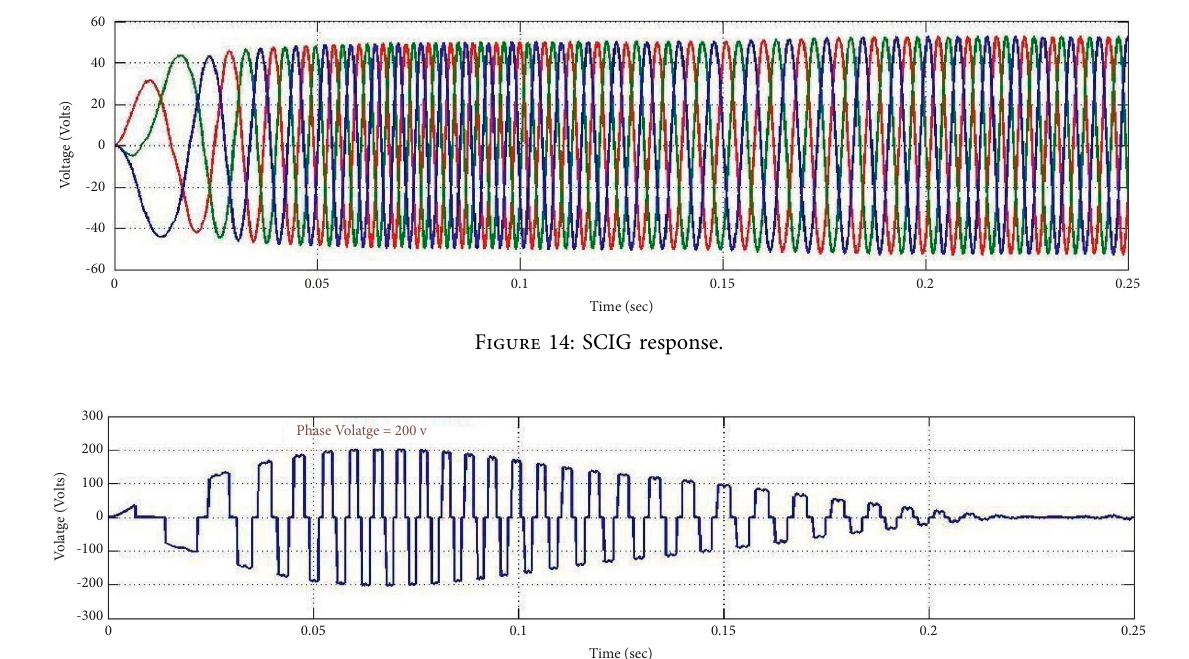
Figure 15: Phase voltage response.